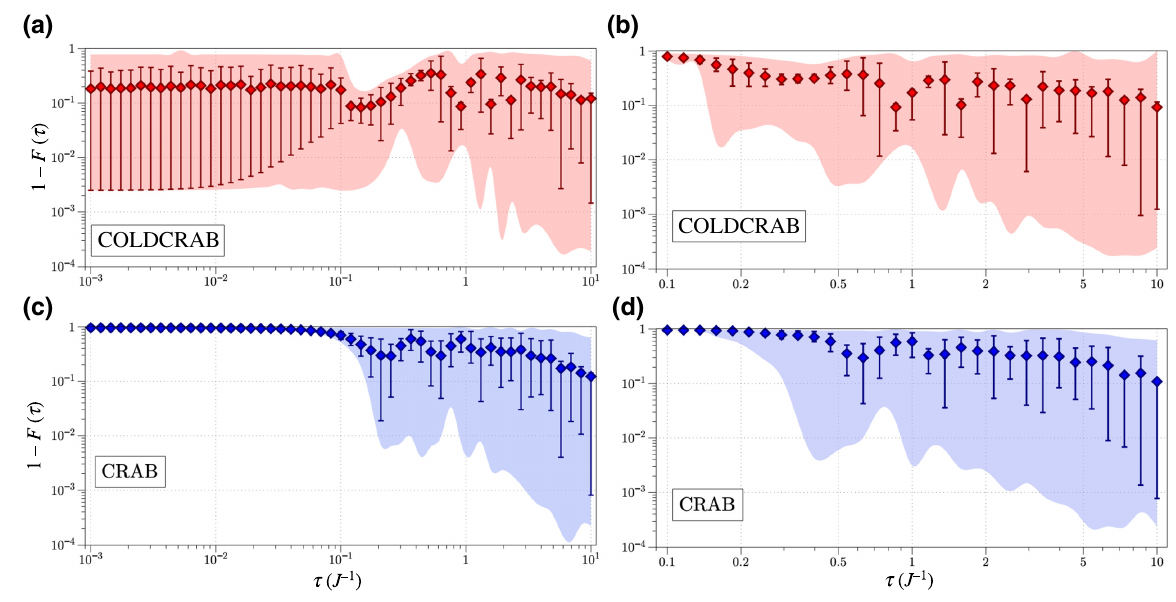
FIG. 10. Plots of the mean fidelities (diamonds) obtained over 500 optimization runs for the Ising spin chain as discussed in the main text. The error bars represent the interquartile range of the data while the shaded region encompasses the minimum and maximum fidelities obtained at each driving time. Panel (a) shows the case of COLDCRAB for the constrained instance, (b) plots the same for CRAB with (c) and (d) showing results for the unconstrained Ising chain